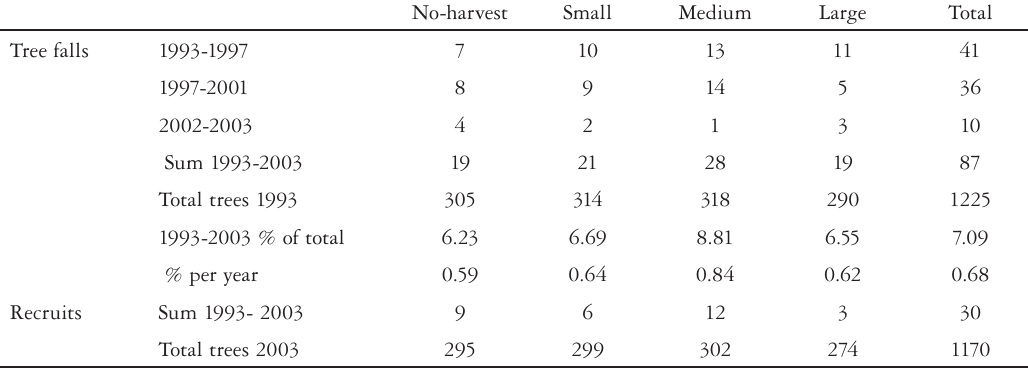
Table 3. Number of tree falls and recruits per treatment as a percentage of standing